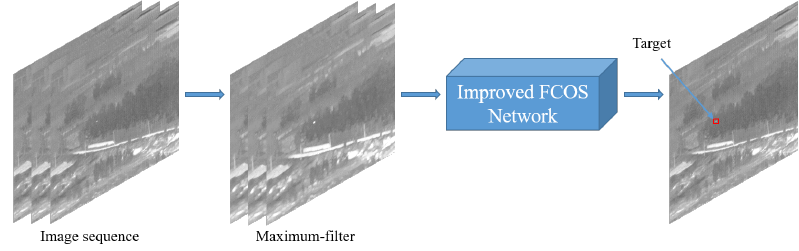
Figure 2. Improved FCOS detection method flow